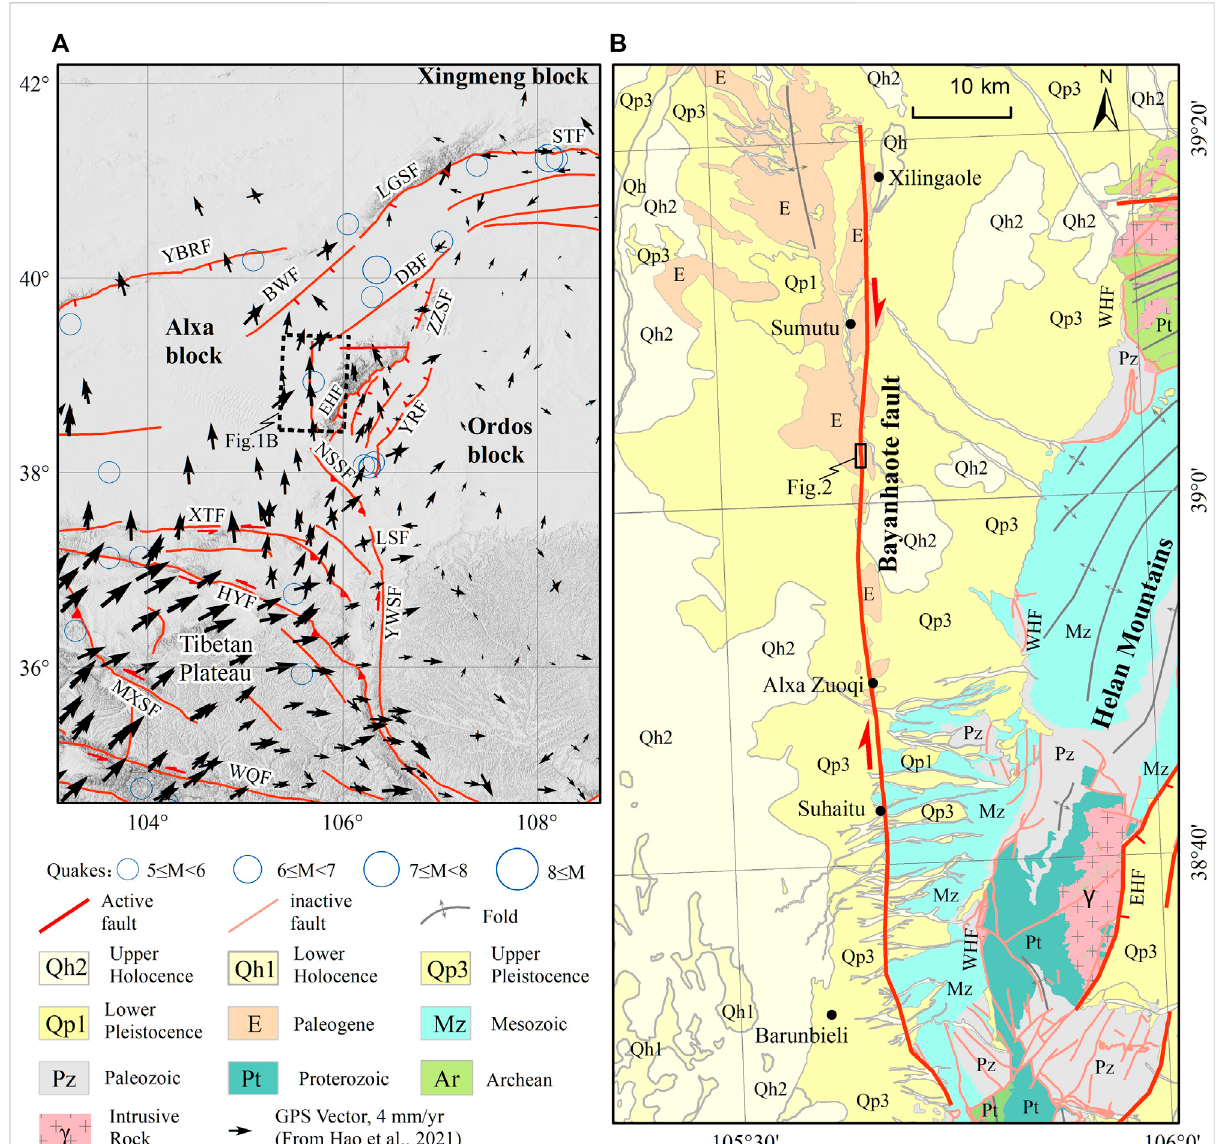
FIGURE 1 Regional geological setting of the Bayanhaote fault. (A) Major active faults, earthquakes, and GPS velocity fi elds in the western margin of Ordos (fault modi fi ed from Xu et al., 2016; earthquake catalog from China Earthquake Network Center; GPS velocity with respect to the Ordos block from Hao et al. (2021). (B) Structure of the Bayanhaote fault with geological background (geological data from 1: 250,000 scale public geological map via geocloud. http://geocloud.cgs.gov.cn). BWF: Bayan Wula fault; EHF: East Helanshan fault; HYF: Haiyuan fault; LGSF: Langshan fault; LSF: Luoshan fault; MXSF: Maxianshan fault; NSSF: Niushoushan fault; STF: Seerteng fault; WHF: West Helanshan fault; WQF: West Qinlin fault; XTF: Xiangshan-Tianjingshan fault; YBRF: Yabrai fault; YWSF: Yunwushan fault; ZZSF: Zhuozishan